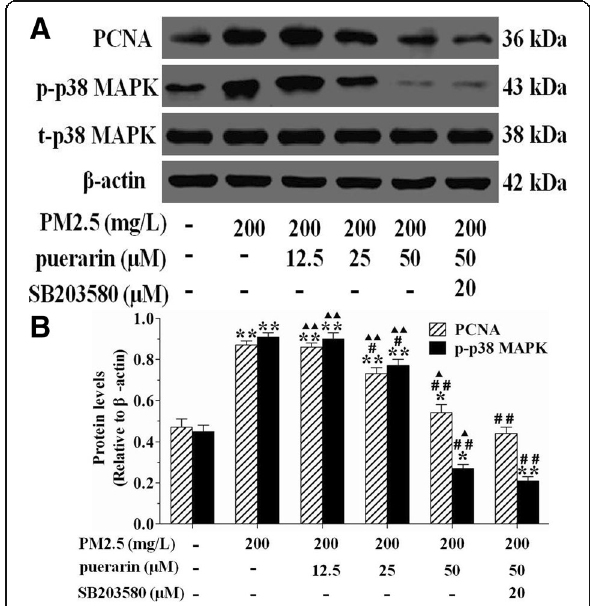
Fig. 6 Effect of puerarin on the expressions of p-p38 MAPK and PCNA in VSMCs. Cells were pre-treated with puerarin at different concentrations (0, 12.5, 25, 50 μ M) or p38 MAPK inhibitor SB203580 (20 μ M) for 1 h and followed by the addition of 200 mg/L PM2.5 for 24 h. Then the expressions of PCNA, p-p38 MAPK and t-p38 MAPK in VSMCs were determined by western blot, β -actin was used for the protein loading control. a Representative western blot results for PCNA, p-p38 MAPK and t-p38 MAPK in VSMCs. b Quantitative analysis of western blot results was presented. The results are presented as mean ± SEM. n = 3. Compared to the untreated cells, * P < 0.05, ** P < 0.01; compared to 200 mg/L PM2.5 group, # P <0.05, ## P <0.01; compared to the co-incubation of puerarin with SB203580 group, ▲ P <0.05, ▲▲ P